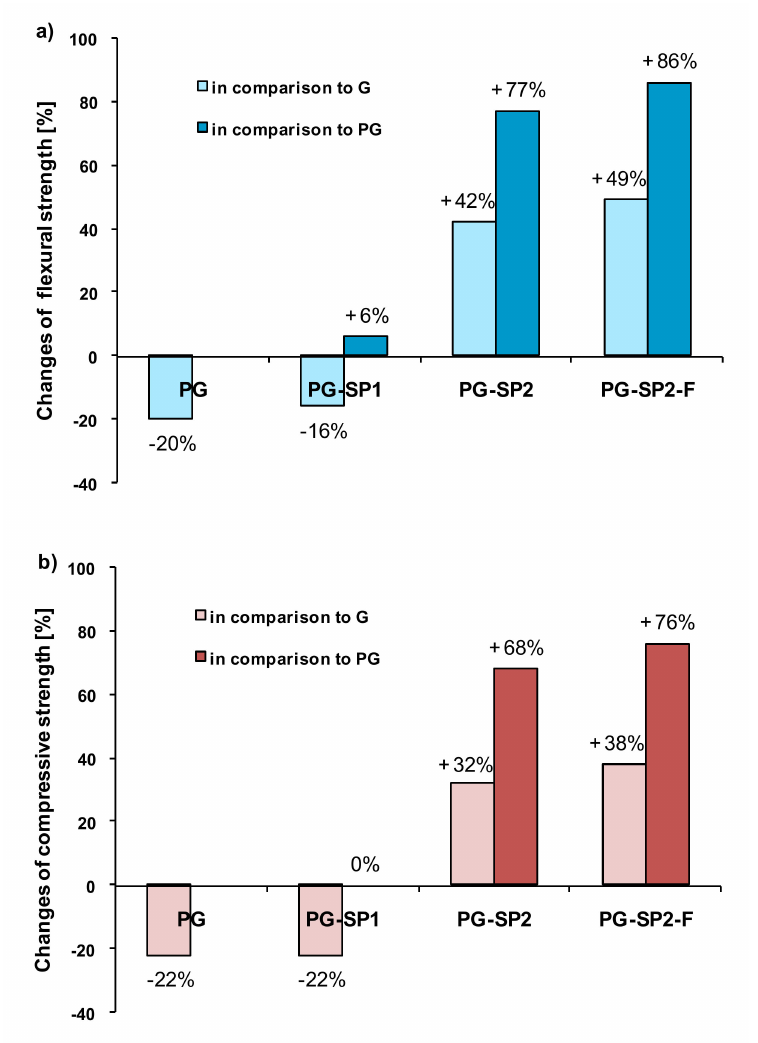
Figure 2. The changes in the mechanical properties of modified gypsum plasters: ( a ) flexural strength; ( b ) compressive